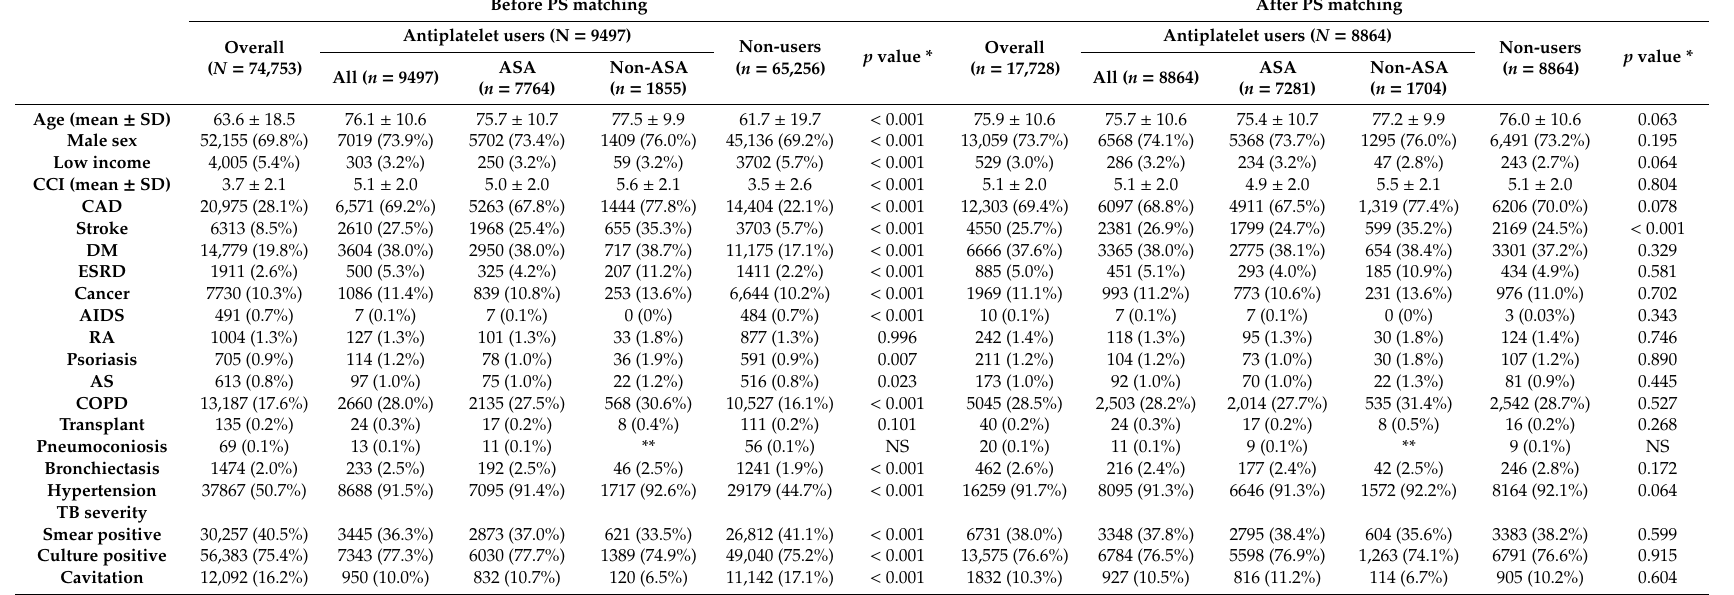
Table 1. Clinical characteristics of tuberculosis patients with and those without antiplatelet